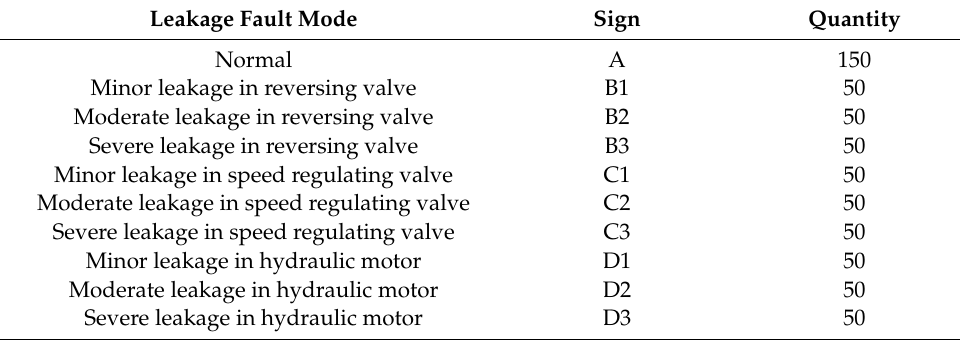
Table 15. Composition of the test set.